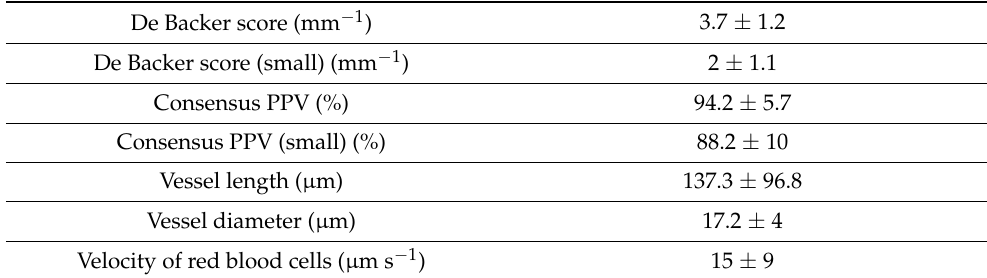
Table 2. Baseline sublingual microcirculation variables.